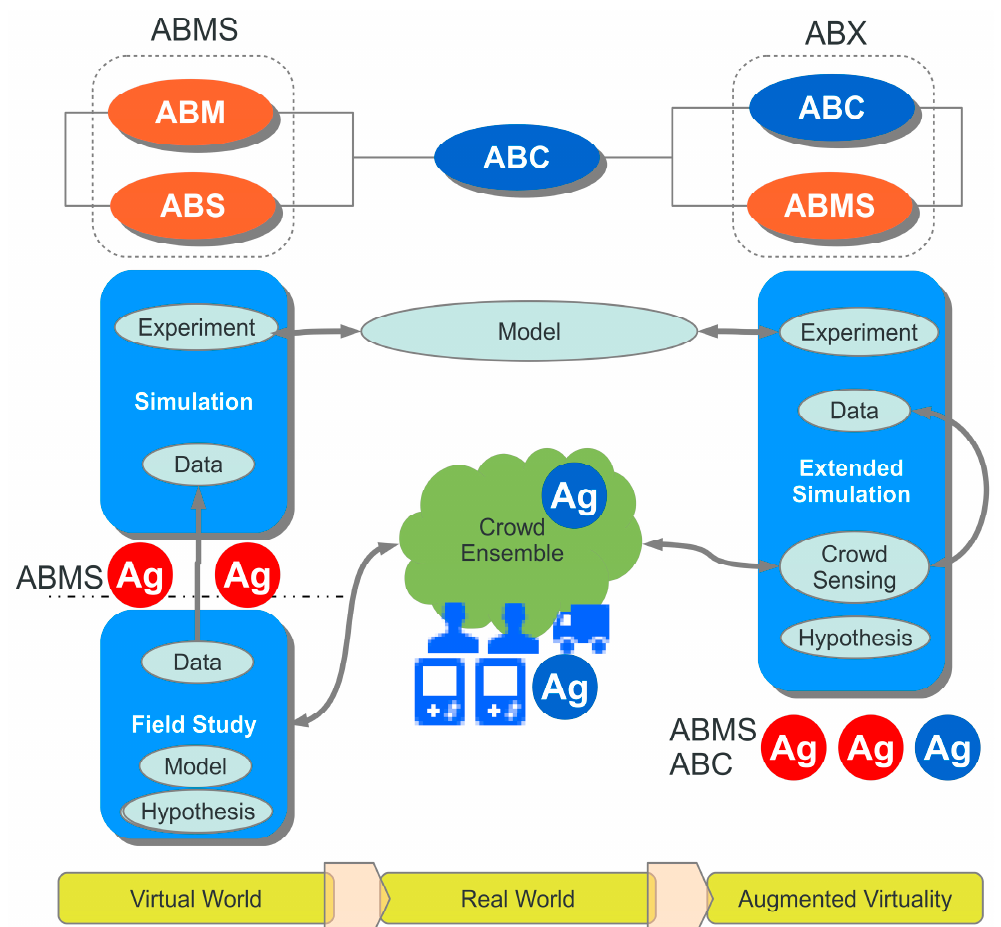
Figure 1. ( Left ) Traditional field studies and agent-based simulation of social systems. ( Right ) New combined agent-based simulation and agent-based crowd sensing enabling bidirectional data exchange.